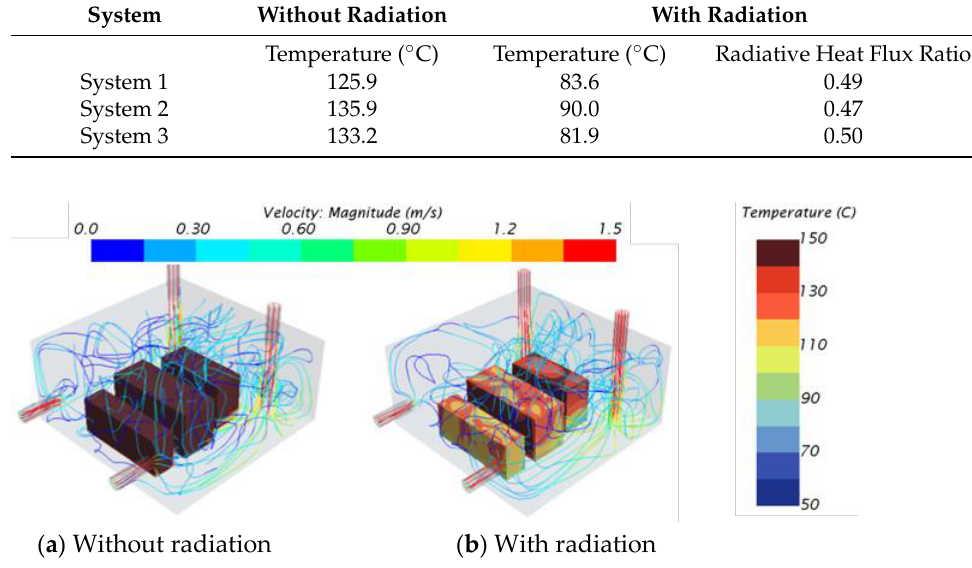
Figure 8. System surface temperature contours and velocity streamlines for the cockpit underfloor equipment bay (Configuration 1).